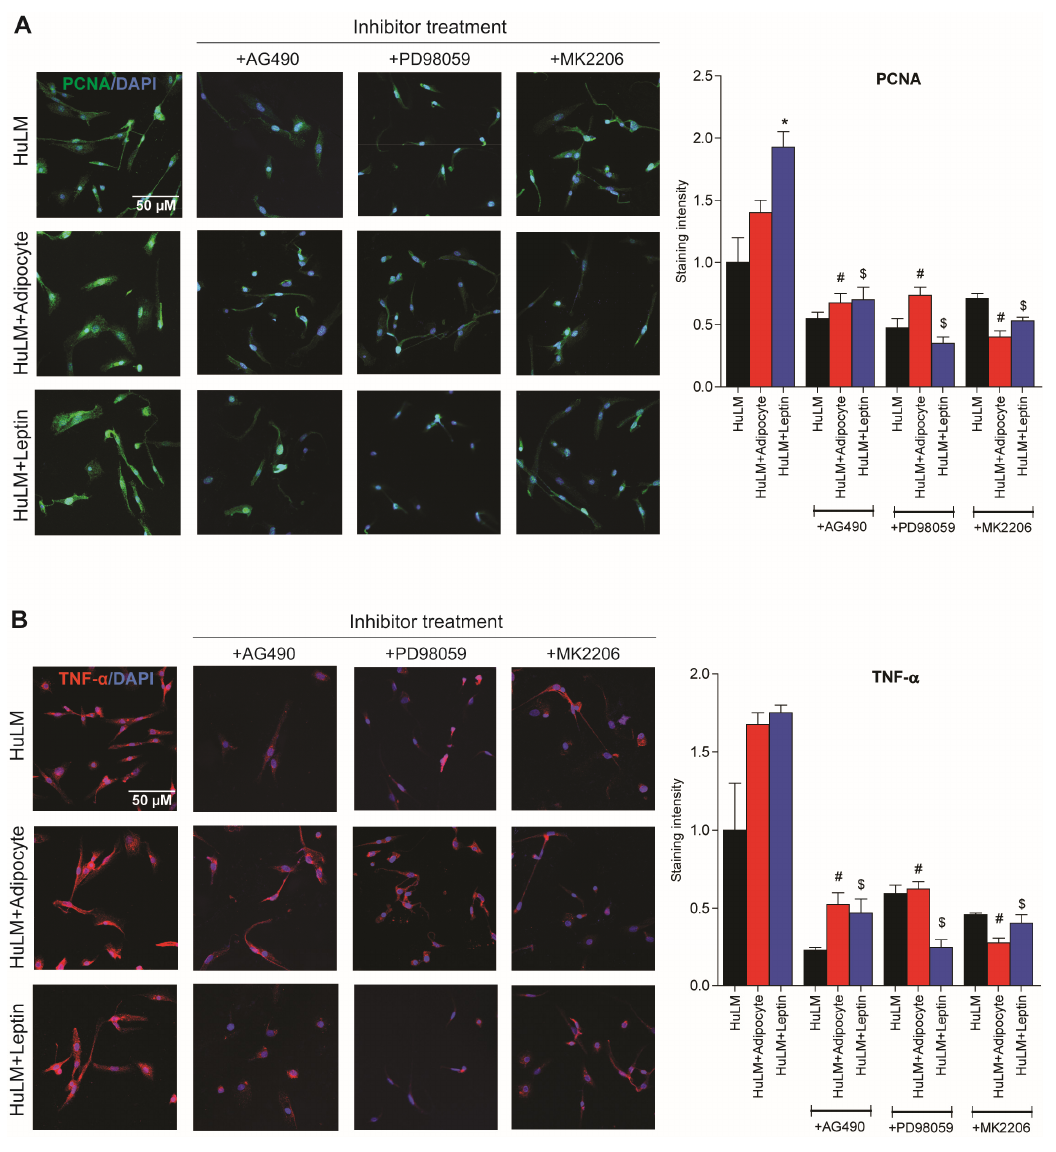
Figure 7. Effect of STAT3, ERK, and AKT inhibitor treatment in PCNA and TNF- α expression. Immortalized human leiomyoma cells (HuLM) were cocultured with SW872 adipocyte cells for seven days and treated with leptin for 24 h. After seven days cocultured and 24 h leptin treatment, leiomyoma cells were treated for additional 24 h with the STAT3 inhibitor (AG490), the ERK inhibitor (PD98059), and the AKT inhibitor (MK2206). We performed immunocytochemistry to confirm the presence of ( A ) PCNA (green fluorescence), ( B ) TNF- α (red fluorescence), and DAPI (blue fluorescence). All images were taken with a Zeiss AxioPlan 2 microscope system (20× magnification). Scale bar, 50 μ m. Images were measured and quantified using ImageJ. *, p < 0.05 vs. the single cell type culture; #, p < 0.05 vs. coculture; $, p < 0.05 vs. leptin treated cells.